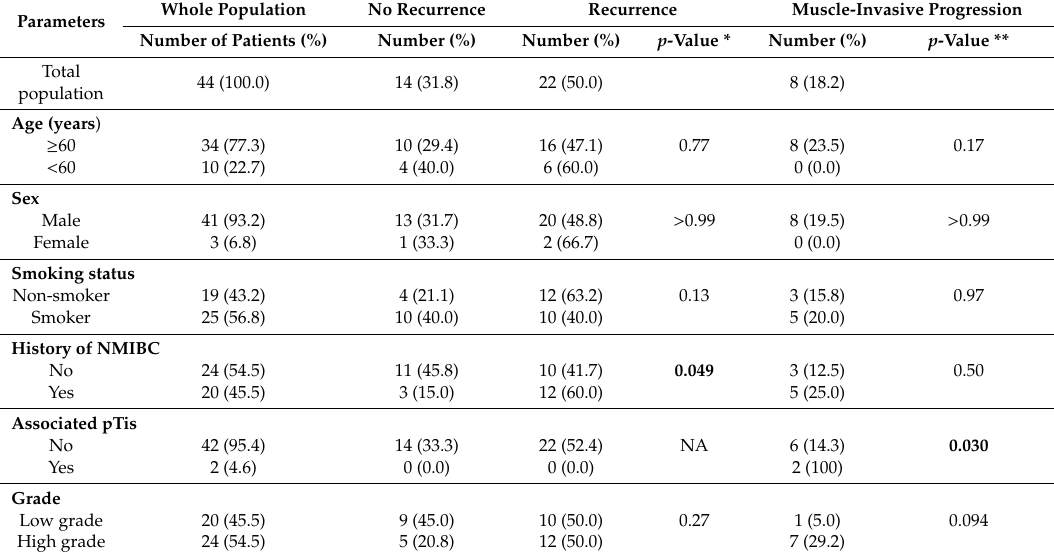
Table 1. Clinical, biological, pathological, and survival characteristics of the 44 non-muscle-invasive bladder cancers